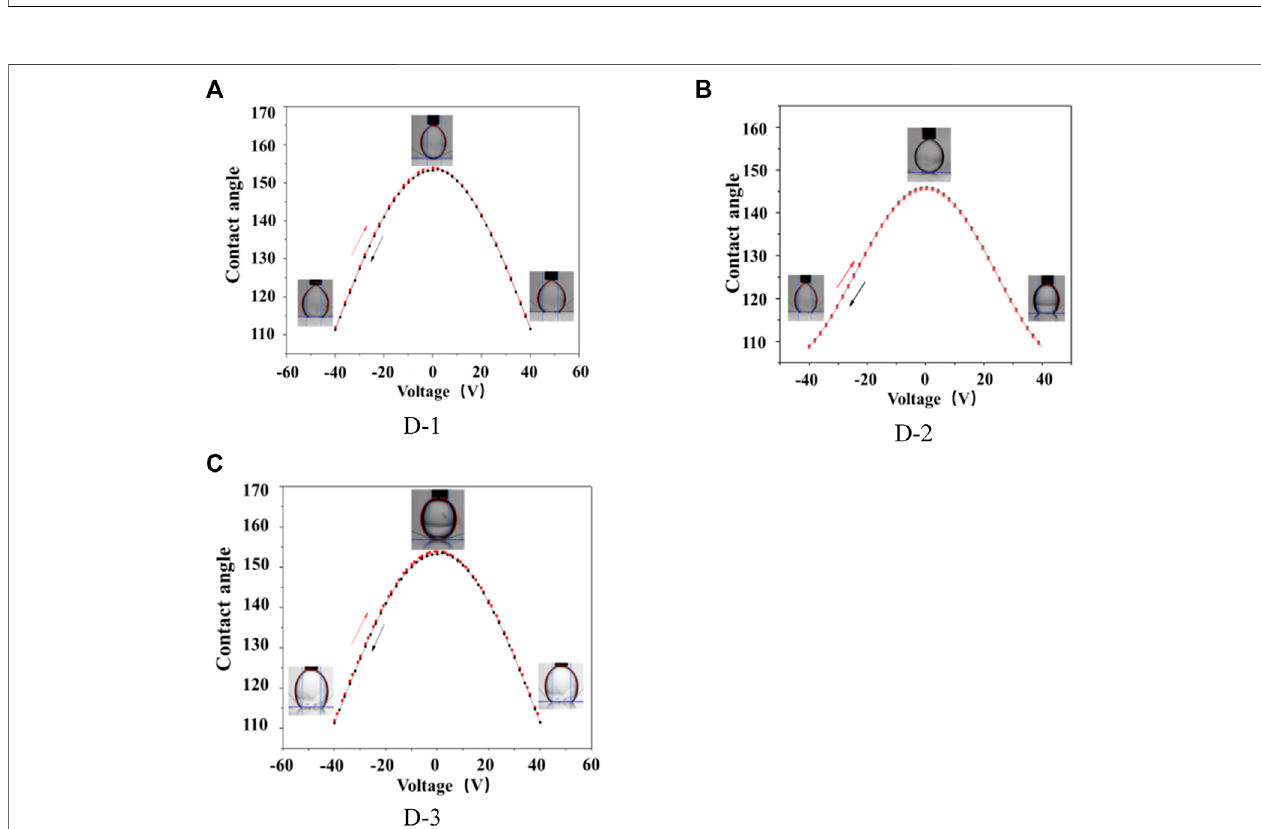
Frontiers in Physics |